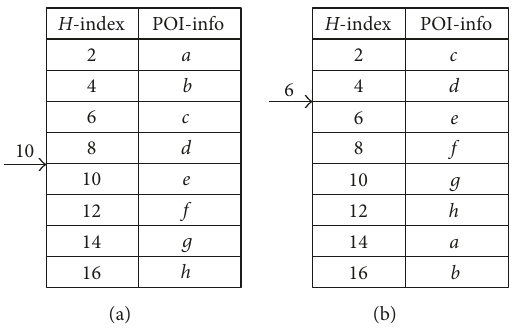
Figure 5: (a) The evenly distributed POIs. (b) After circularly shifting, the shift- 𝐻 -index = (10 + 2 × 6) mod 16 = 6